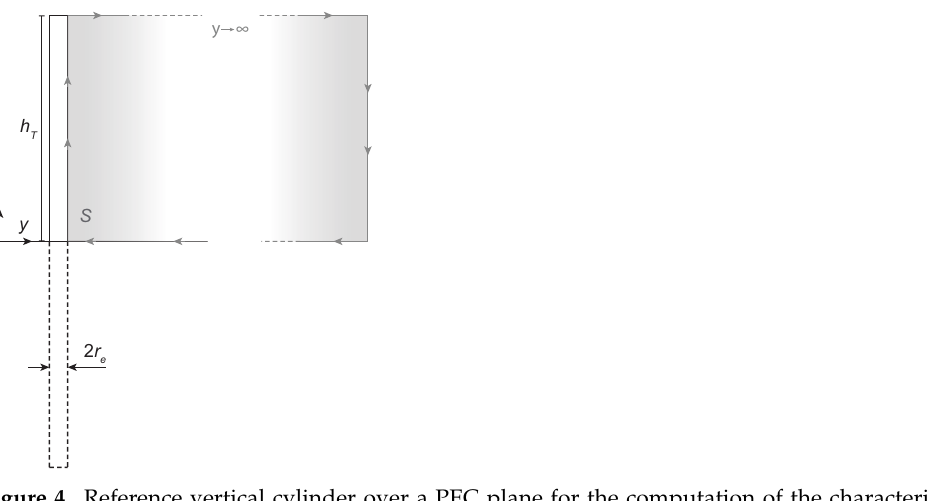
Figure 4. Reference vertical cylinder over a PEC plane for the computation of the characteristic impedance according to the revised Jordan